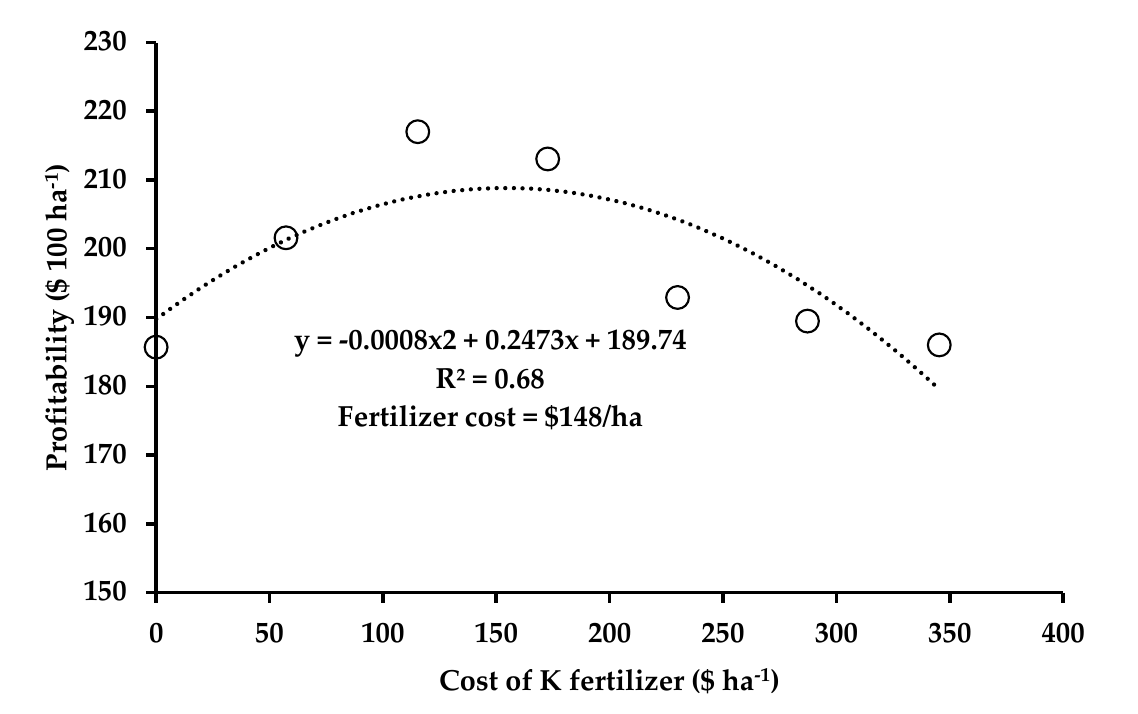
Figure 3. Profitability in response to potassium (K) application rate. Each growing season (2018-2021), seven K rates, 67 kg·ha 1 K 2 O (K67), 135 kg·ha − 1 K 2 O (K135), 202 kg·ha − 1 K 2 O (K202), 269 kg·ha − 1 K 2 O (K269), 336 kg·ha − 1 K 2 O (K336), and 404 kg·ha − 1 K 2 O (K404) in the form of muriate of potash or